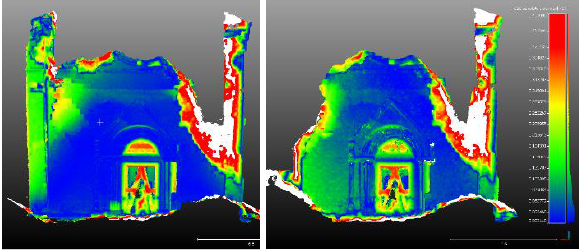
Figure 13. The main façade collapse comparison in 2 steps: a) t1-t2; b) t1-t3. The represented range values are 0<v<0.2m (white values>0.2m). (Figure 14) the progressive evolution of collapse a series of break lines traces were detected in t1 in relation to the ones identified in t2 before the decisive collapse.